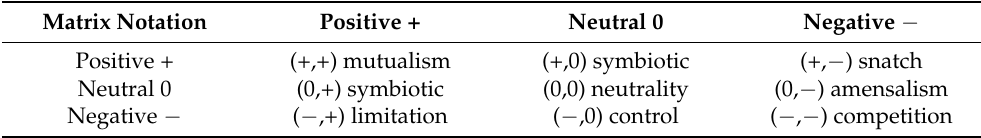
Table 3. Relationships between components of the network. Matrix